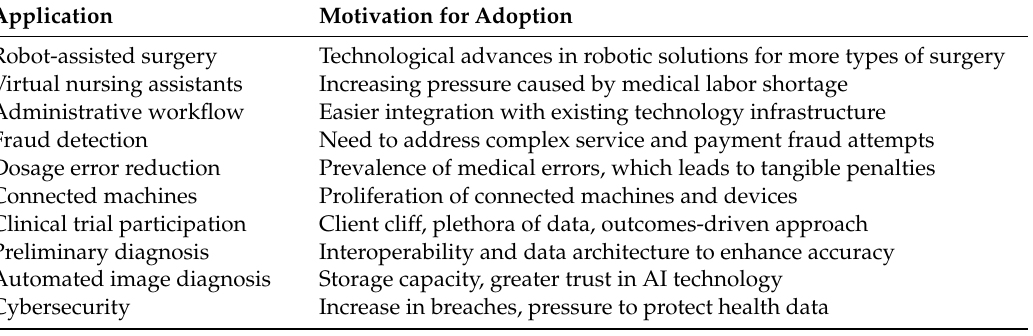
Table 2. AI applications and motivation for adoption in healthcare practice, derived from Park [60].